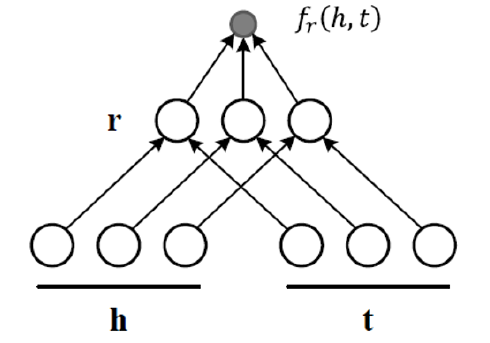
Figure 5. Illustration of DistMult and ComplEx semantic matching-based models. Taken from [12]. DistMult [33] restricts r to a diagonal matrix ( diag ( · ) ), decreasing the parameter count to O ( d ) per relation and, therefore, the complexity of the algorithm. The scoring function is then defined